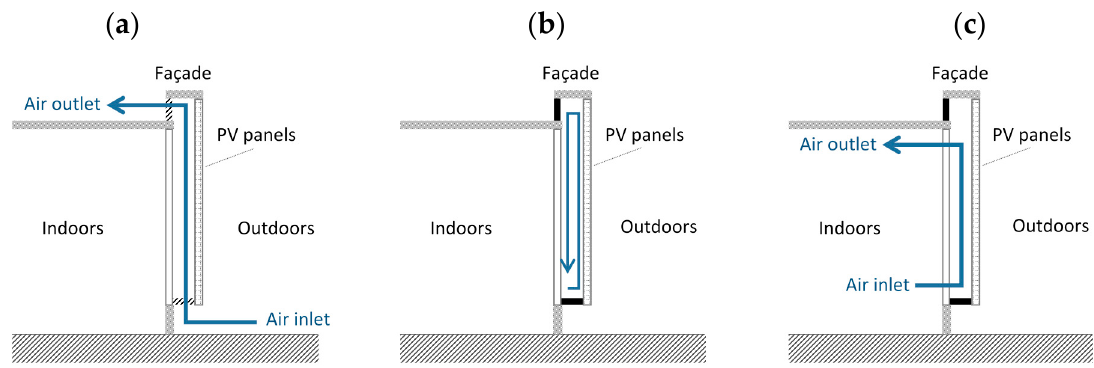
Figure 2. Schemes of the façade current possible operating modes; ( a ) air circulation, and ( b ) additional insulation; and proposed operating mode ( c ) air recirculation.